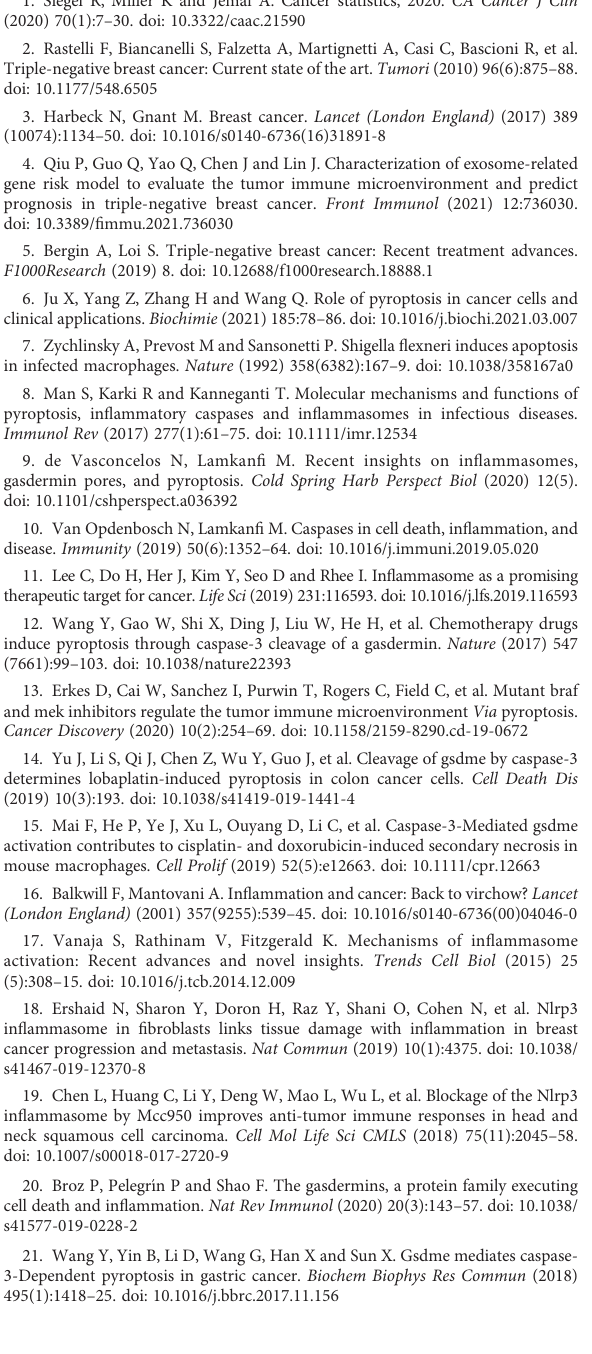
SUPPLEMENTARY FIGURE 3 Immune in fi ltrations of training and validation groups. Relative proportion of immune in fi ltration in METABRIC (A) and GEO (B) sets.